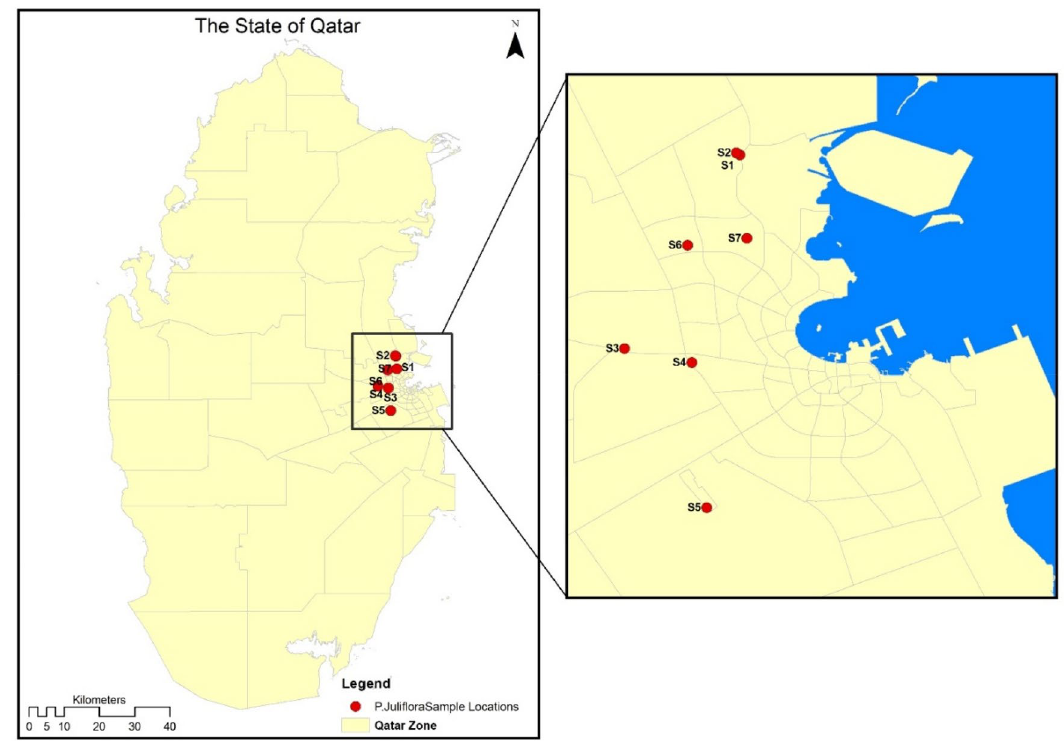
Figure 1. Location map of collection sites of P. juliflora leaf samples (ArcGIS